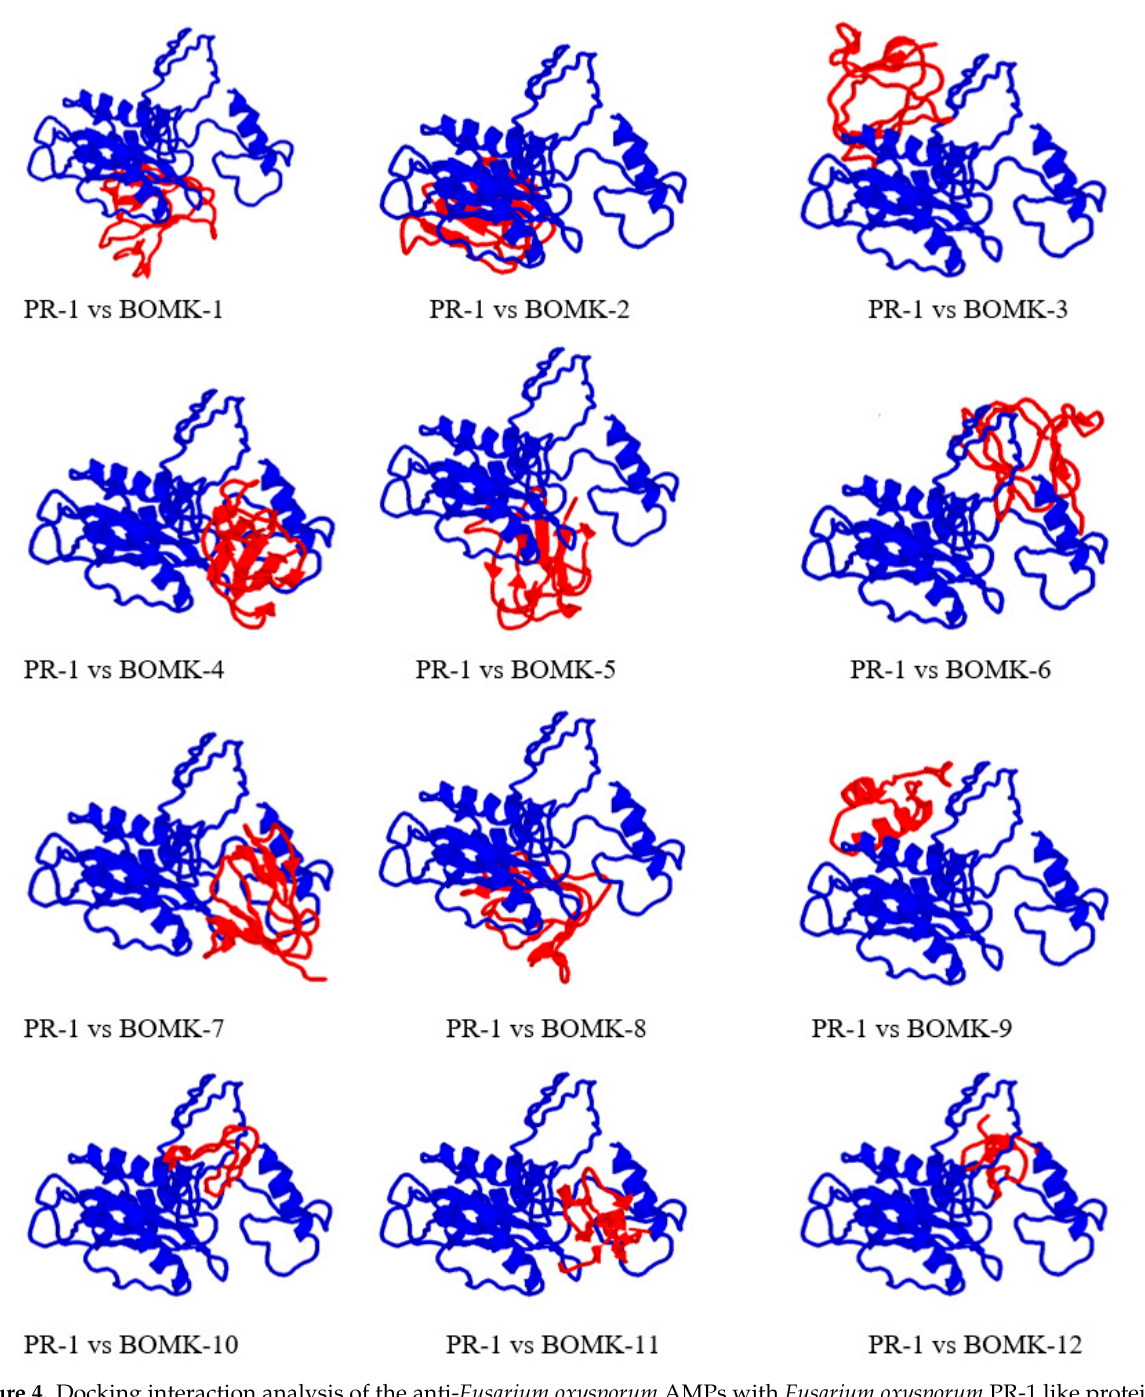
Figure 4. Docking interaction analysis of the anti- Fusarium oxysporum AMPs with Fusarium oxysporum PR-1 like protein, Fpr1. The blue color represents PR-1 like protein (Fpr1), the red is the AMPs.